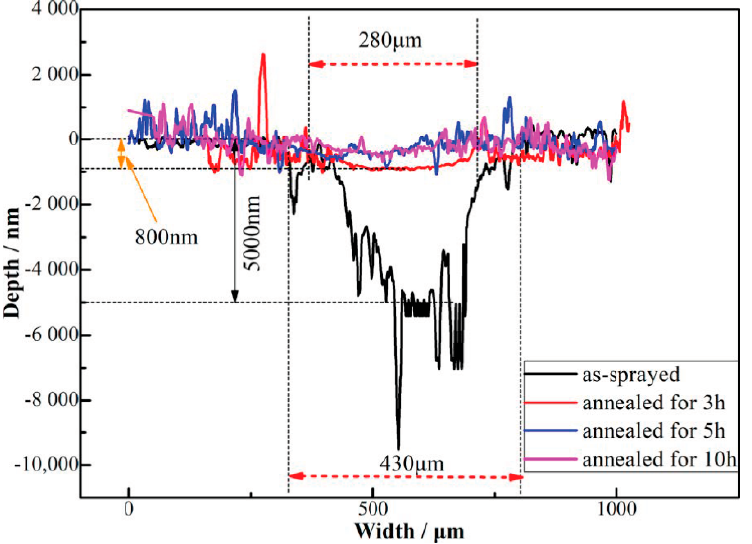
Figure 10. Cross-sectional profiles of the wear tracks after a sliding distance of 1000 m.